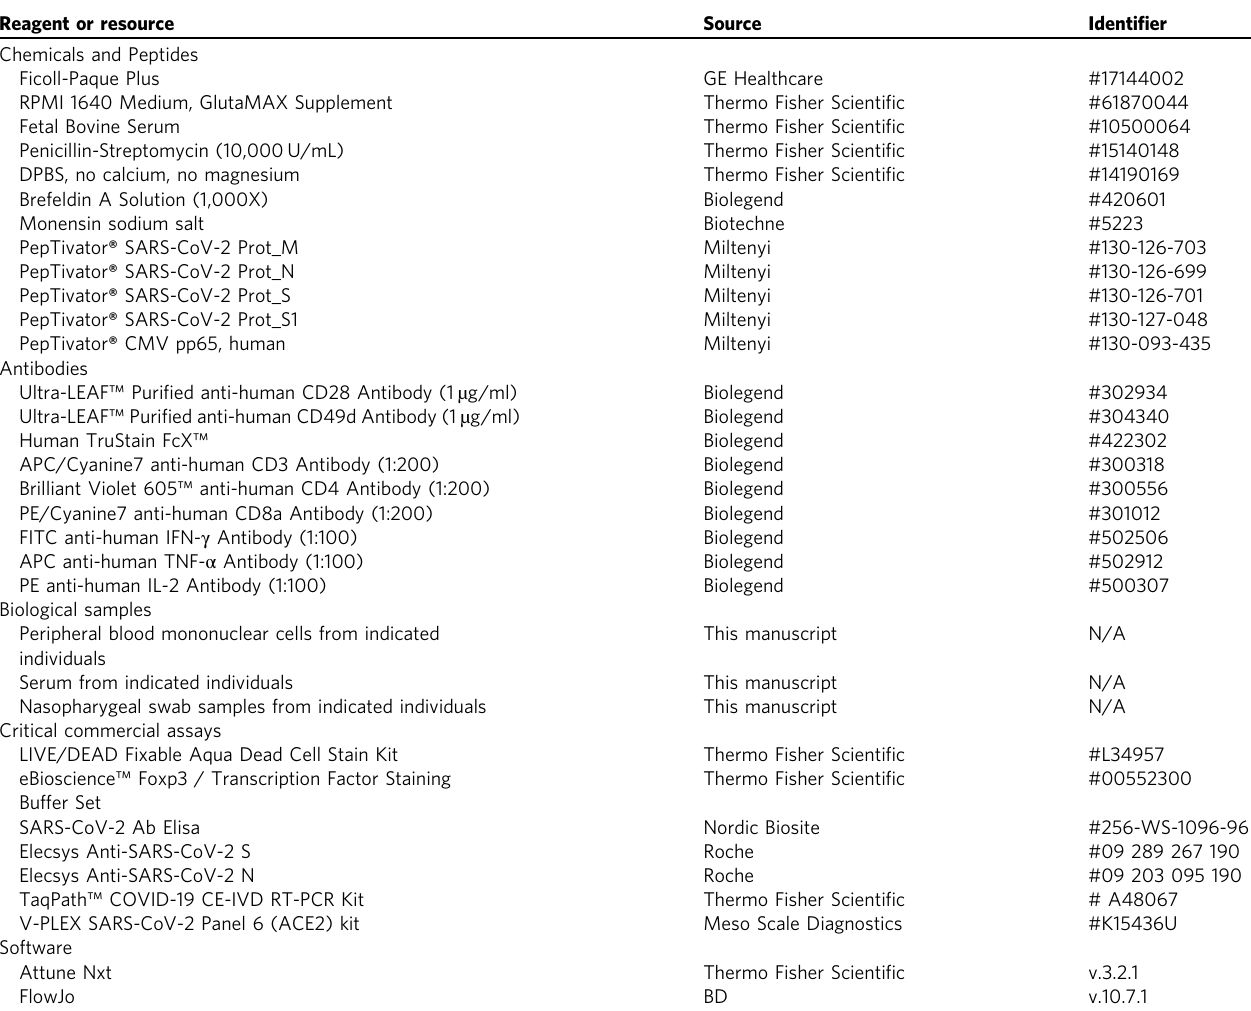
Table 3 Key resources